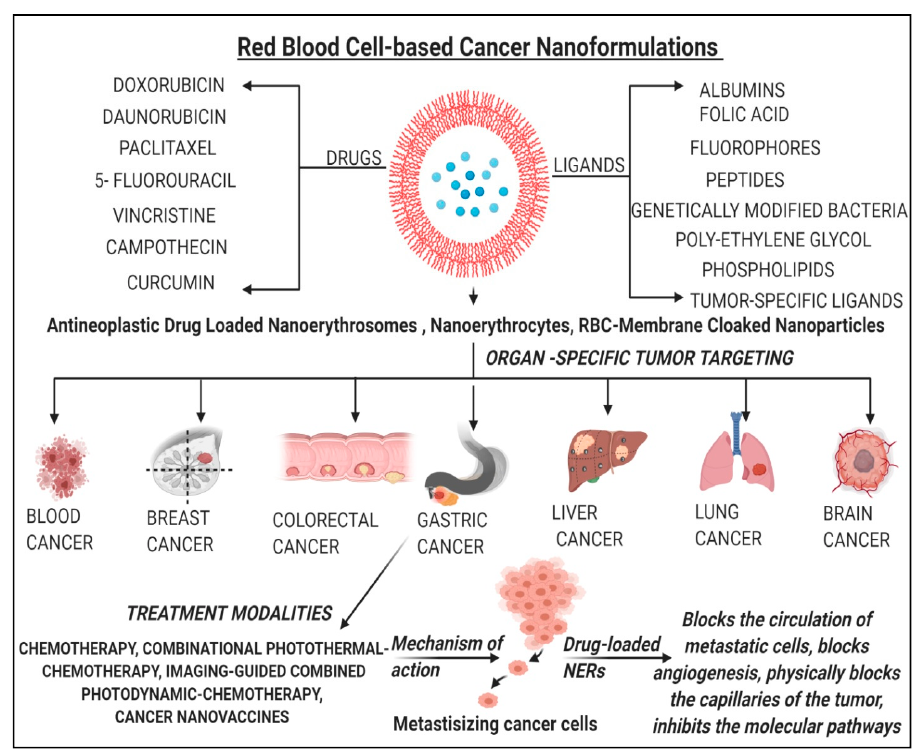
Figure 3. Summary of red blood cell (RBC)-based anticancer nanoformulations (anti-cancer-loaded-NERs) along with their mechanisms.